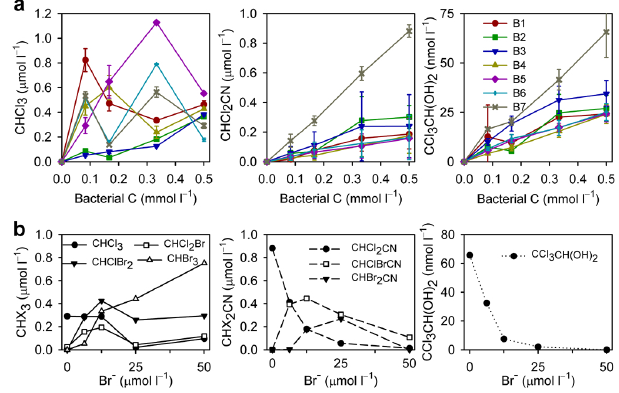
Fig. 1. Formation of some C1/C2 organohalogens by halogenation of bacteria. (a) effects of bacterial C concentrations (at 0.0, 0.083, 0.167, 0.333, and 0.50mmoll − 1 ) . Error bars show SD from 3 repli- cates. (b) effects of bromide (at 0, 6.25, 12.5, 25, and 50µmoll − 1 from KBr) taking Staphylococcus sciuri at 0.5mmol-Cl − 1 as ex- ample. B1: Acinetobacter junii ; B2: Aeromonas hydrophila ; B3: Bacillus cereus ; B4: Bacillus subtilis ; B5: Escherichia coli ; B6: Shigella sonnei ; and B7: Staphylococcus sciuri